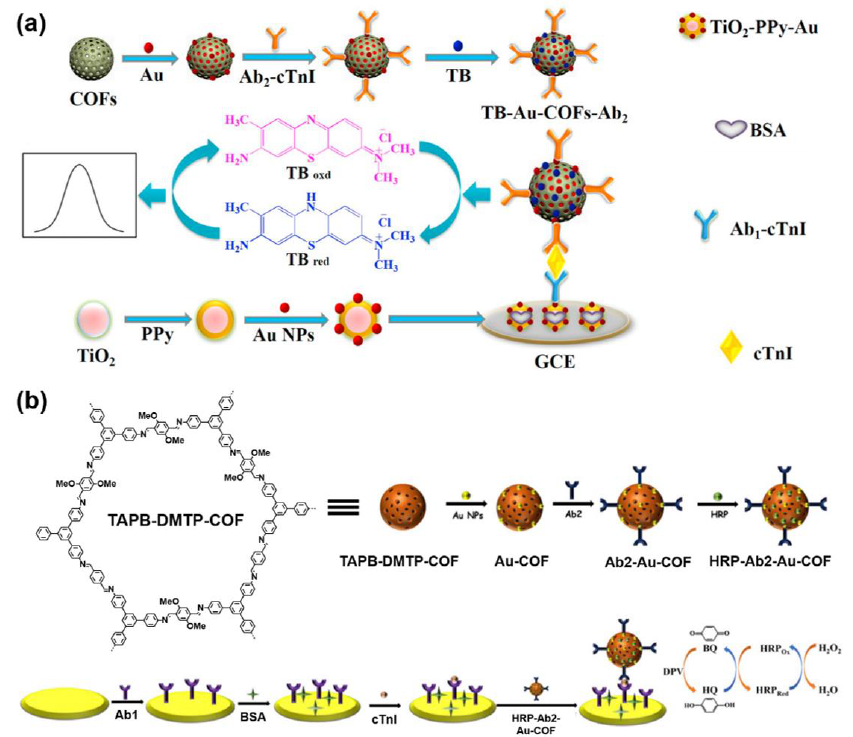
Figure 14. ( a ) A versatile COF-based platform for sensing DNA [171]. Copyright 2017 Royal Society of Chemistry; ( b ) MOF@ COF Heterostructure Hybrid for Dual-Mode Photoelectrochemical − Elect- rochemical HIV-1 DNA Sensing [173]. Copyright 2021 American Chemical